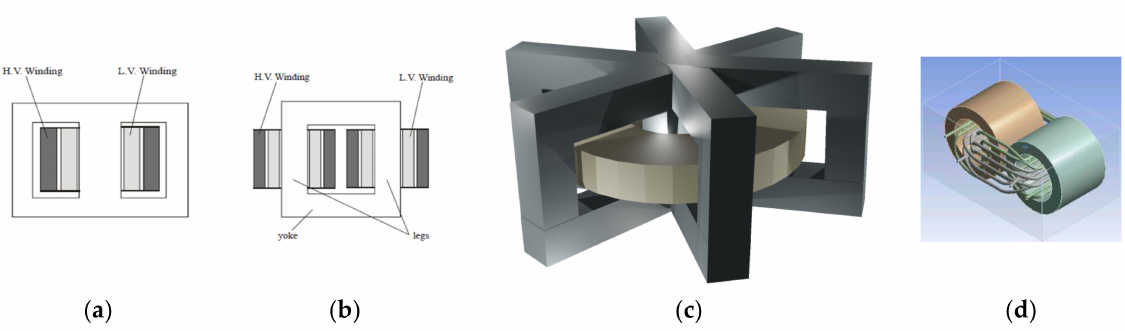
Figure 7. Various HF transformers and their magnetic core structures. ( a ) Shell type ( b ) Core type ( c ) Matrix type ( d ) Coaxial type.